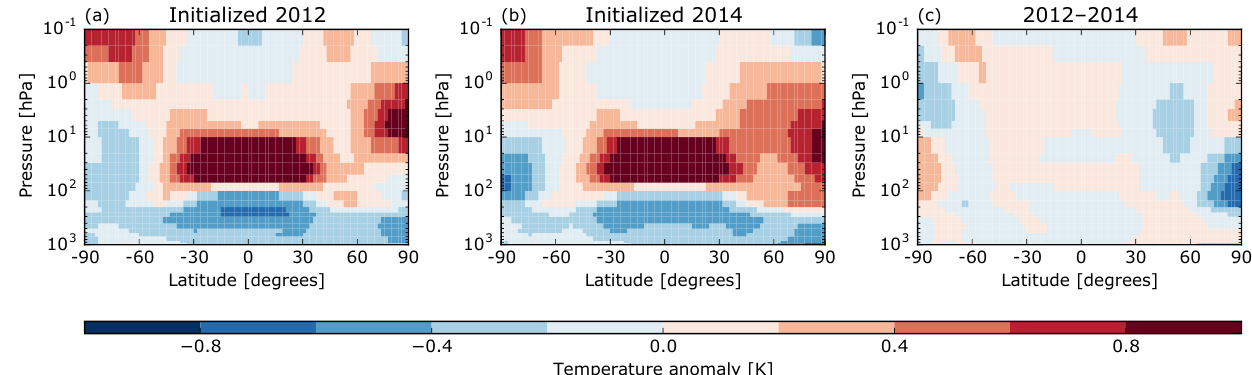
Figure 4. Differences in ensemble mean forecasts of zonal mean air temperature (TA) for prediction years 1–4. (a) Exp-2012 (Pinatubo-2012 – b1-2012), (b) exp-2014 (Pinatubo-2014 – b1-2014), and (c) the difference between the two (exp-2012 – exp-2014).